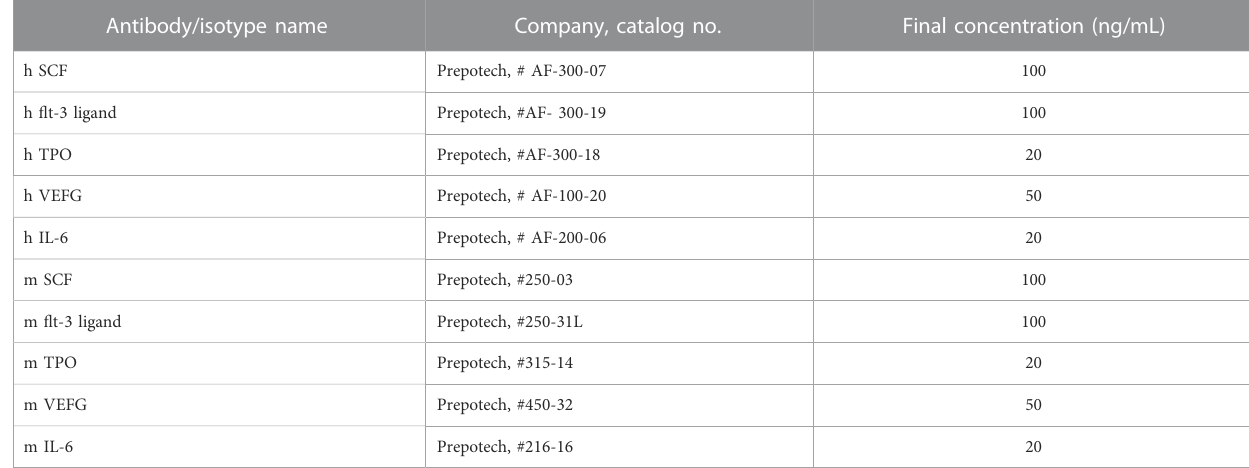
TABLE 1 Growth factors used in 5G culture.